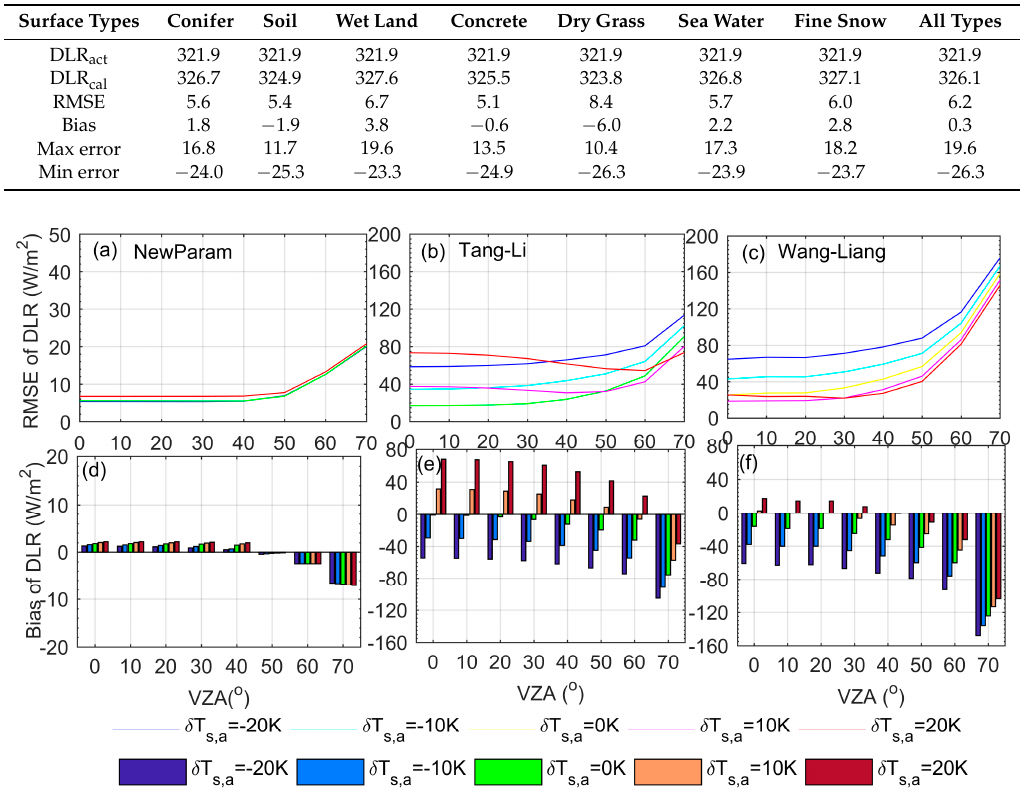
Figure 6. Figures ( a – f ) illustrate the RMSE and Mean-Bias-Error (MBE) between the actual and estimated DLRs versus VZA and δ T s,a for conifer surface and for NewParam ( a , d ), Tang-Li algorithm ( b , e ), and Wang-Liang algorithm ( c , f ),